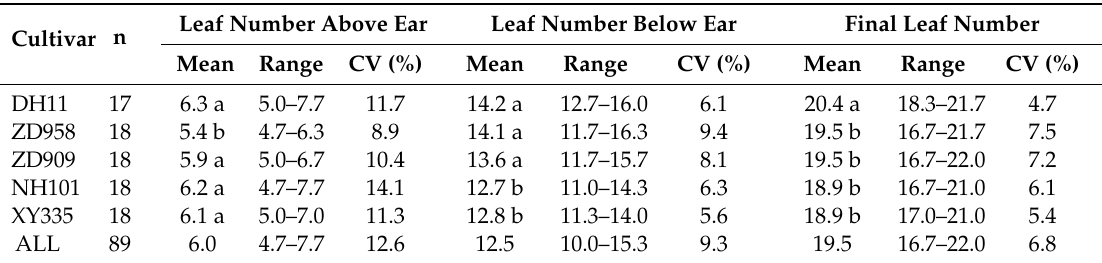
Table 3. Leaf numbers above and below the primary ear and final leaf numbers of di ff erent maize cultivars across all locations during 2015 and